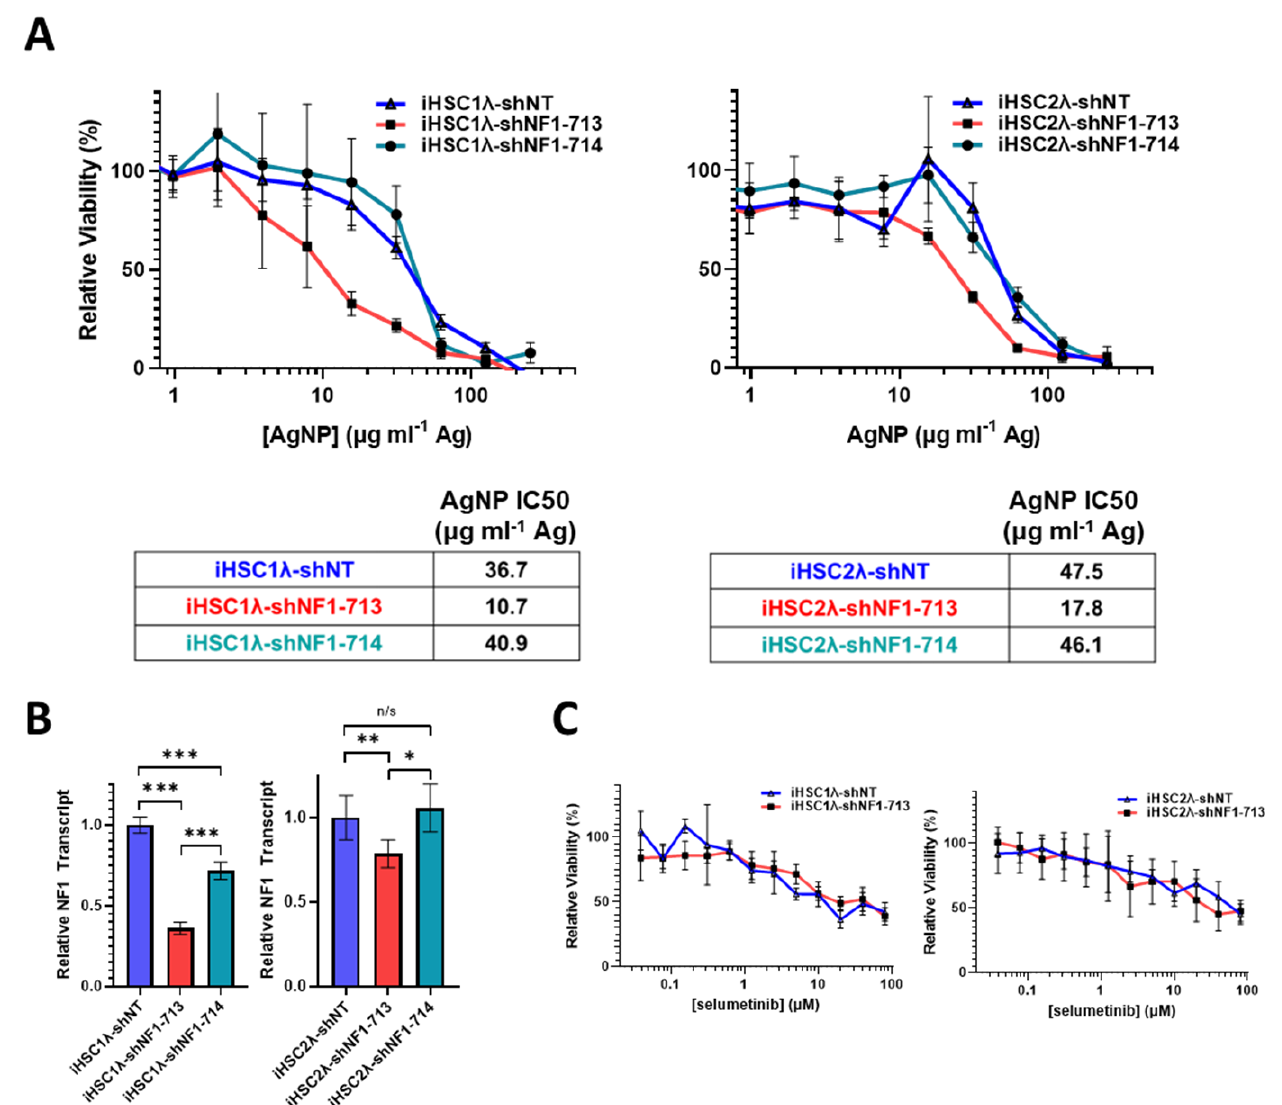
Figure 6. Knockdown of neurofibromin increases sensitivity to AgNPs in normal Schwann cells, with no change in sensitivity to plexiform neurofibroma standard of care selumetinib. Normal Schwann cell lines iHSC1 λ and iHSC2 λ were transfected with non-targeting control shNT or shNF1 (713 or 714) and puromycin selected. ( A ) iHSC1 λ -shNT, -shNF1-713, and -shNF1-714 (left) or iHSC2 λ -shNT, -shNF1-713, and -shNF1-714 (right) were treated with AgNP (0–500 μ g mL − 1 Ag) for